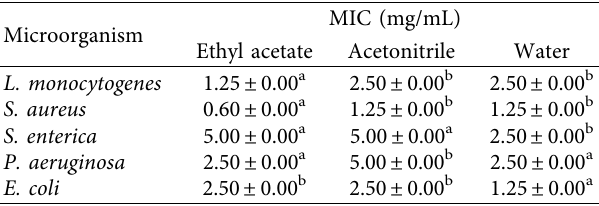
Table 3: MIC values of three extractives from Punica granatum (pomegranate) peel.